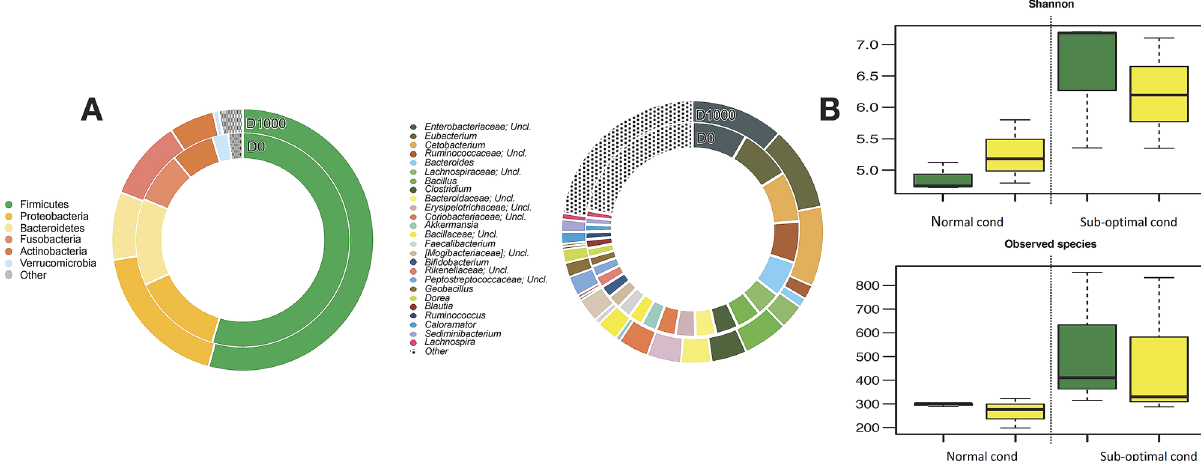
Figure 5. Intestinal microbiota from sea bass Dicentrarchus labrax fed with D0 and D1000 diets before and after the suboptimal rearing condition. ( A ) Average phylogenetic profiles of the gut microbiome of sea bass are provided at phylum (left) and genus (right) level; Phyla and genus which represent < 1.5% of the autochthonous community were included in ‘Others’. ( B ) Alpha diversity of the sea bass GM for all diet assumption was estimated with observed species and Shannon metrics (yellow circle: supplemented, green circle: control). After the suboptimal rearing conditions, the GM of sea bass in both D0 and D1000 is characterized by a significant increase of diversity compared to normal conditions ( P = 0.01; Wilcoxon rank-sum